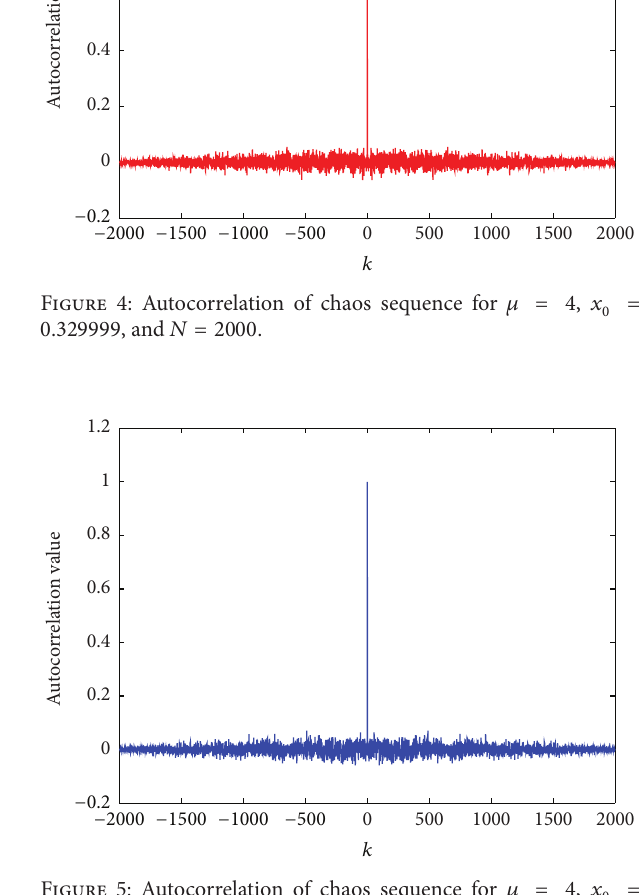
Figure 5: Autocorrelation of chaos sequence for 𝜇 = 4 , 𝑥 0 = 0.329998 , and 𝑁 = 2000